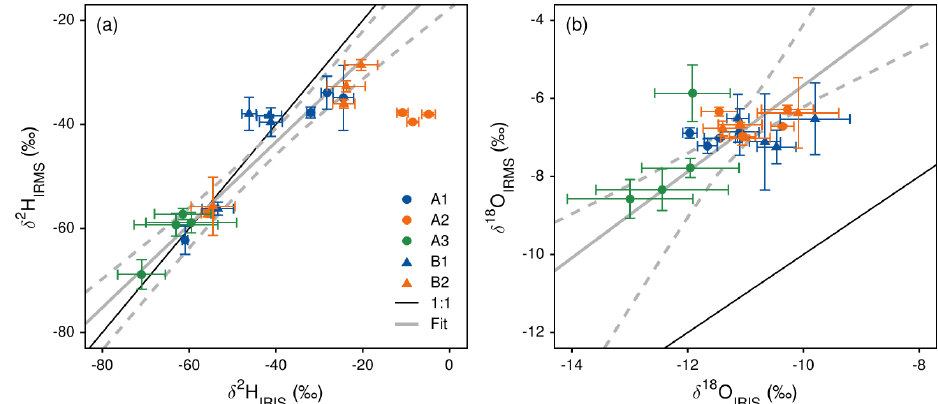
Figure 2. In situ measured xylem water isotopes ( δ 2 H IRIS ) and comparison to results obtained by cryogenic vacuum extraction after destruc- tive sampling and measurement with mass spectrometry ( δ 2 H IRMS ). Reprinted with permission from Volkmann et al. (2016a).